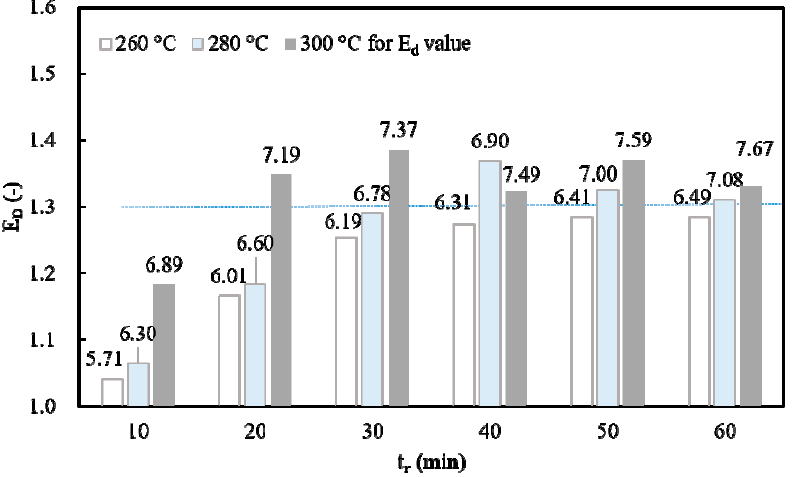
Figure 4. Energy densification (E D ) of JMS T with logSF numbers on the top of the bar (as defined by Equation (4)) in various torrefaction